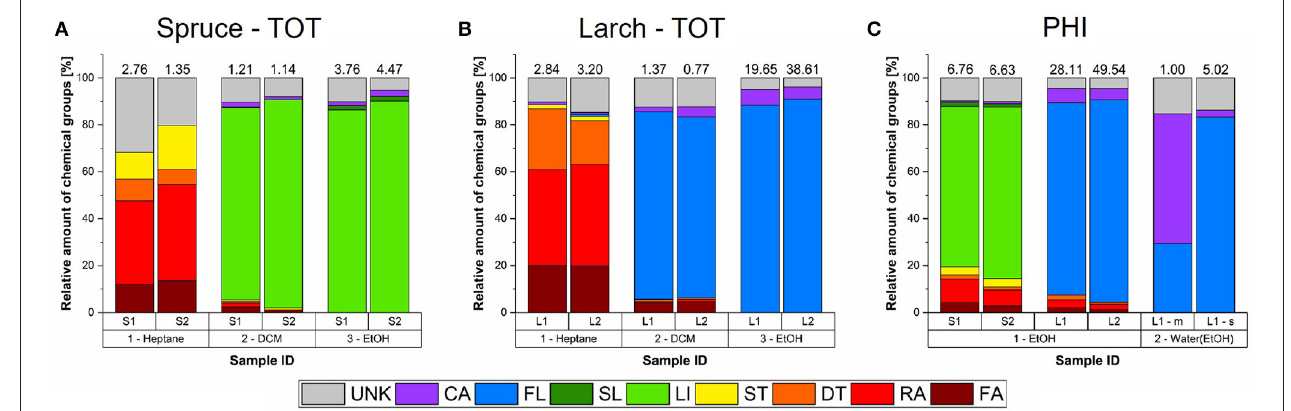
FIGURE 4 | Relative chemical composition of all the detected solvent fractions and extraction strategies for milled Norway spruce and Kurile larch. For reference the absolute chromatographic yields are shown as numbers above the respective bars in mg/g dry wood ( n =1). (A) Total extracted samples (TOT) of spruce (S). Each tree is shown separately, as indicated by the index. (B) Total extracted samples of larch (L). (C) Ethanol (EtOH) fractions of the hydrophilic extracted samples (PHI). The water-ethanol fractions were only run for larch 1 (sticks (s) and milled (m) extracts). Indexes before solvent designations indicate the sequence by which the solvents were used. DCM, Dichloromethane; FA, fatty acid; RA, resin acid; DT, diterpenoids; ST, sterols; FL, flavonoids; SL, sesquilignans; LI, lignans; CA, carbohydrates and other structural components; UNK,